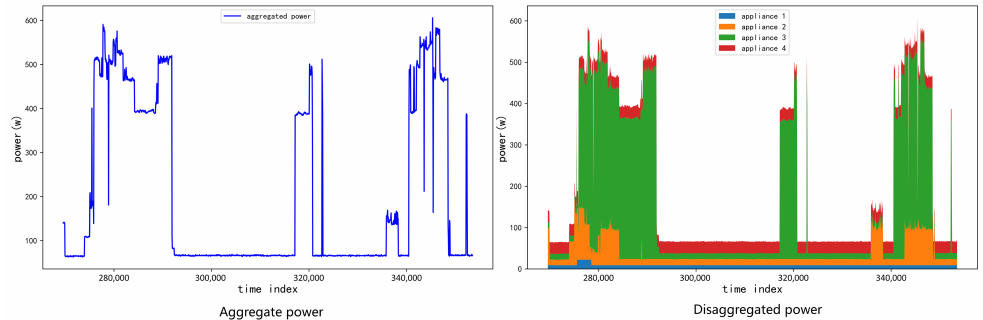
Figure 10. NILM results with the assistance of appliance identification.